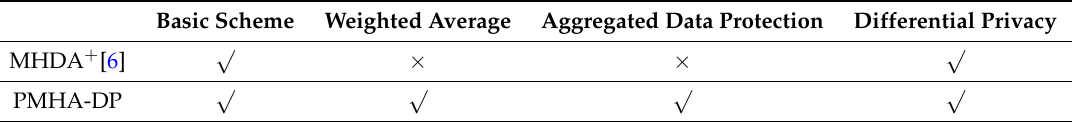
Table 1. Comparison of the functionality of additive aggregation.